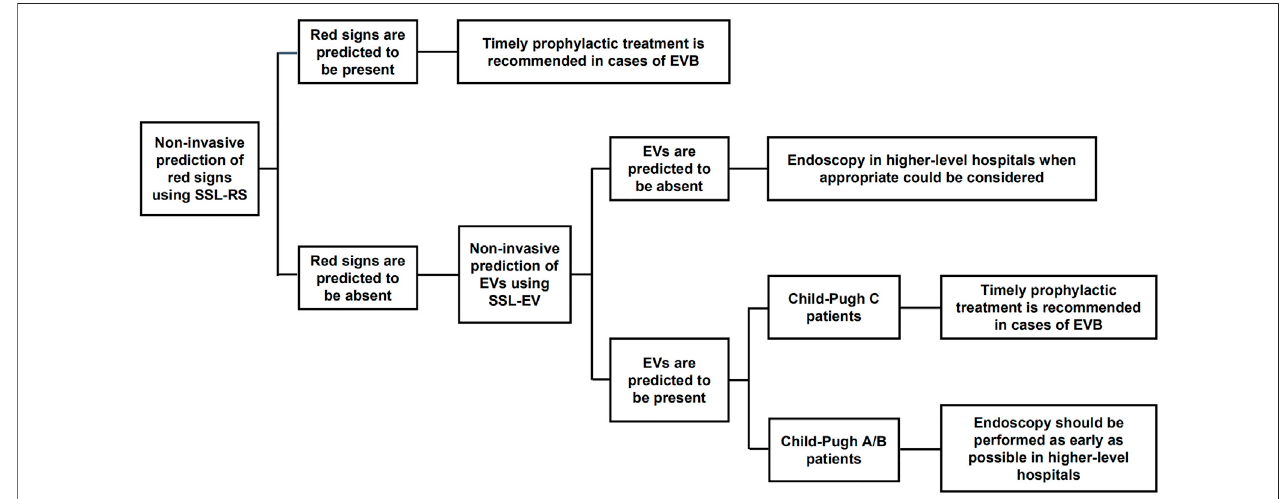
FIGURE4| ThecombinationofSSL-RSandSSL-EVpredictionmodelscontributestobetterdecisionmakinginclinicalpractice.SSL-RSpredictionmodel,spleen diameter-splenic vein diameter-lymphocyte ratio-red signs prediction model; SSL-EV prediction model, spleen diameter-splenic vein diameter-lymphocyte ratio- esophageal varices prediction